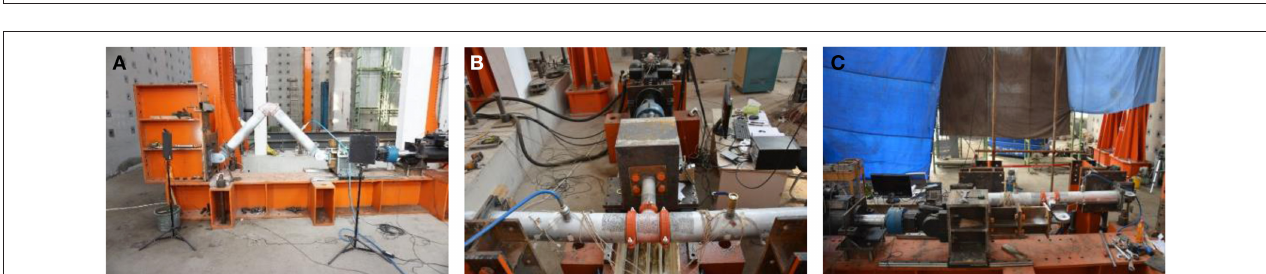
FIGURE 8 | Specimens after installation (A) Elbow joint (B) Tee joint (DN150) (C) Tee joint (DN80).